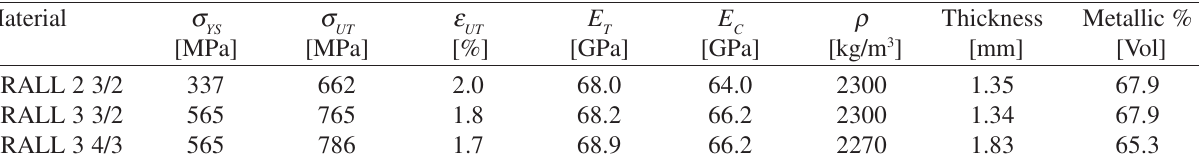
Table 1. Basic mechanical properties of ARALL 2 3/2, ARALL 3 3/2 and ARALL 3 4/3 laminates (in the fibre direction) 15